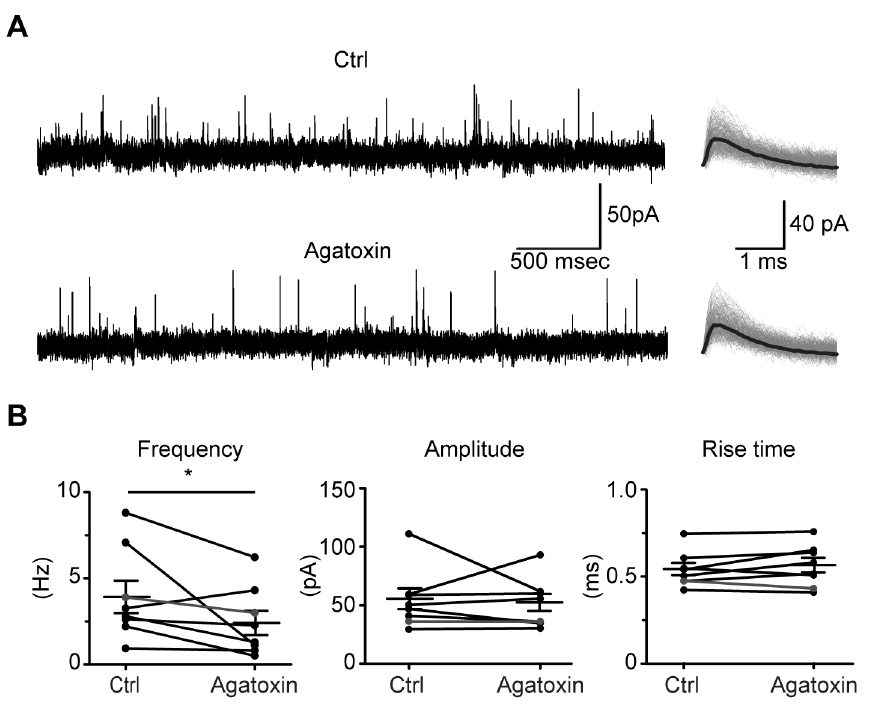
Figure 6. P/Q-type Ca ++ channels mediate evoked miniature events at older ages. A ) (Left) Example current trace collected after 100 Hz stimulation (P12 cell), showing reduction in sPSC frequency after application of the P/Q-type antagonist v -agatoxin IVA. (Right) Superimposed sPSCs (150 events) in control and in v -agatoxin IVA, for the neuron shown in left; average traces in black. B ) Mean frequency, but not amplitude or rise time, of sPSCs was affected by P/Q-block with v -agatoxin IVA. Black lines connect control and drug measurements from individual cells. Cell in A shown in gray.